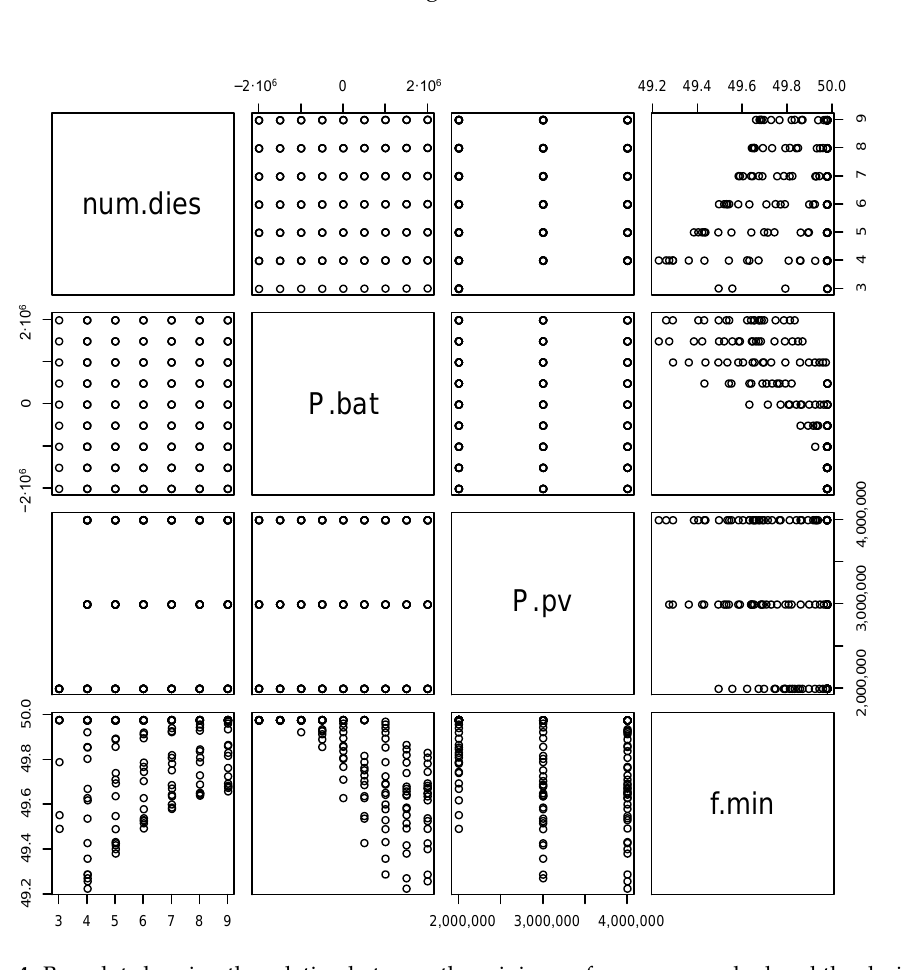
Figure 4. Box plot showing the relation between the minimum frequency reached and the